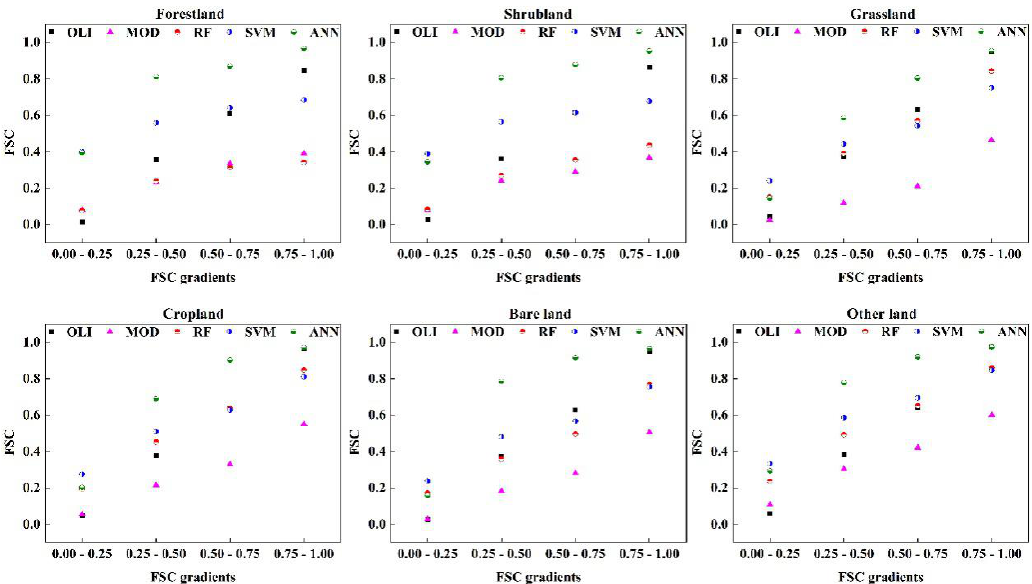
Figure 8. FSC comparisons among Landsat OLI (OLI), MOD10A1 (MOD) and random forest (RF), support vector machine (SVM) and back-propagation artificial neural network (ANN) under various land cover types and FSC gradients.